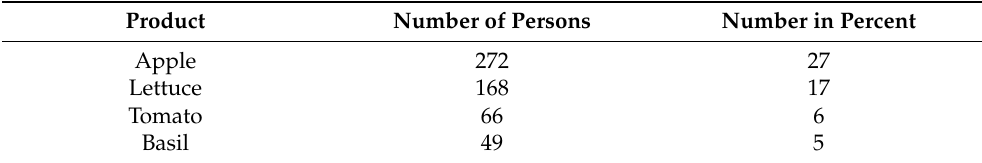
Table A2. Daily consumption of fresh fruit, vegetables, and herbs. n = 1016.